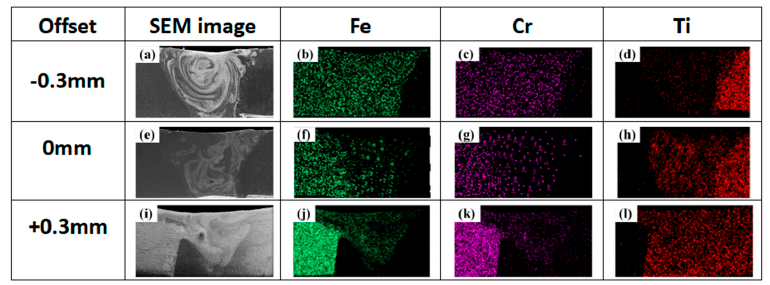
Figure 6. Map scanning results of elements distribution for 301L/TA2 welded joints with different offsets: ( a , e , i ) SEM images of scanning areas; ( b , f , j ) Fe distribution; ( c , g , k ) Cr distribution; ( d , h , l ) Ti distribution.